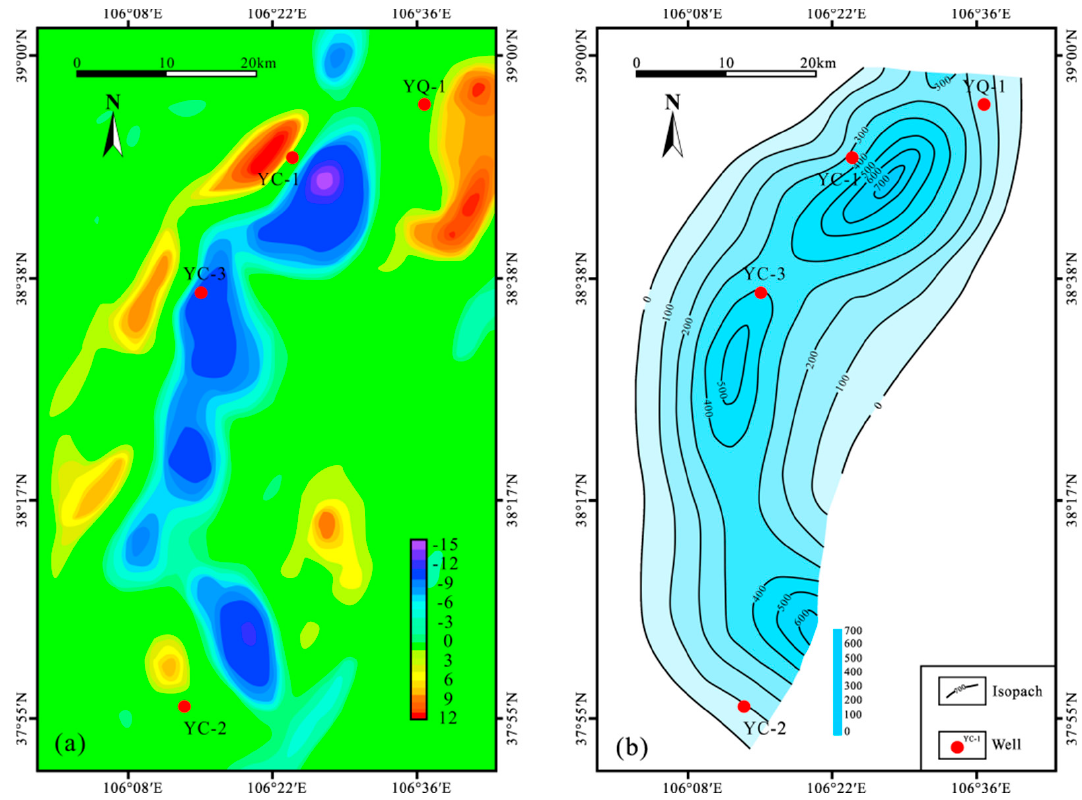
Figure 3. The thickness distribution of mudstone in Qingshuiying Formation, Yinchuan Graben. ( a ) Distribution of Bouguer gravity anomaly in Qingshuiying Formation, Yinchuan Graben (Adapted from [31]); ( b ) Mudstone thickness of Qingshuiying Formation in Yinchuan Graben.